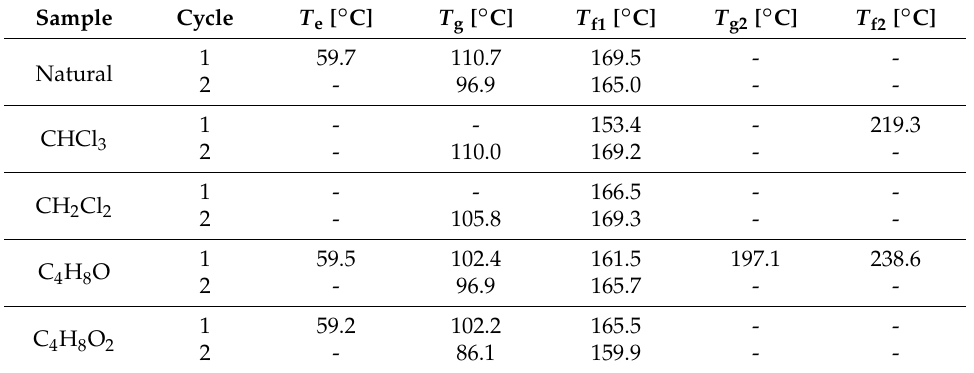
Figure 3. Differential scanning calorimetry analysis of the two thermal cycles (C 1 and C 2 ) for arbitrary samples: ( a ) untreated sample; ( b ) sample treated with CHCl 3 . Table 4. Numerical data from the differential scanning calorimetry analysis of the